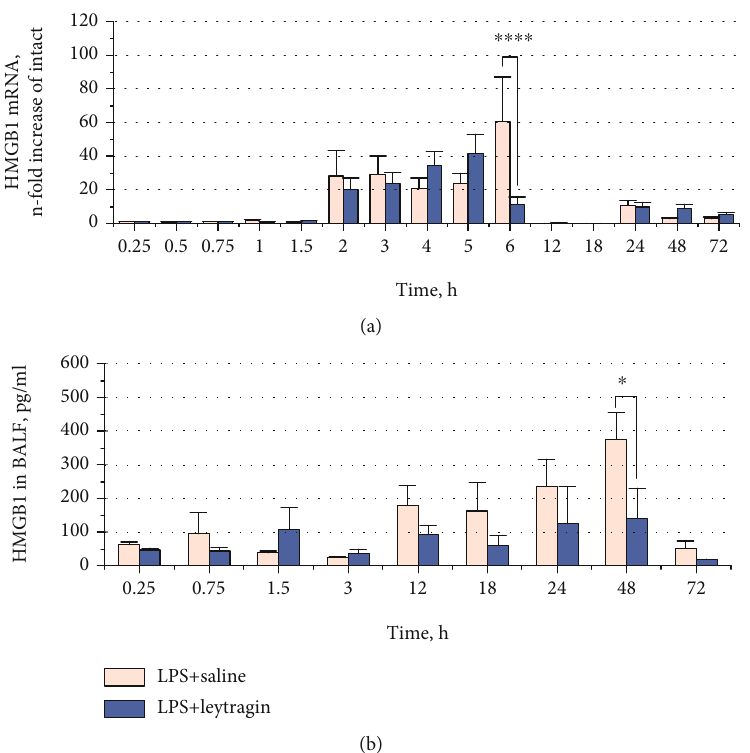
Figure 2: E ff ects of leytragin administration on LPS-induced elevations of HMGB1 release and mRNA levels. (a) Time courses for HMGB1 protein release into BAL in LPS-induced mice that received a single inhalation of leytragin or saline; 27 – 29 animals per group were used (3 – 4 per indicated time point). (b) The relative levels of HMGB1 mRNA in LPS-induced mice receiving inhalation of leytragin or saline; 75 animals per group were used (5 per indicated time point); ∗ p < 0 : 05 , ∗∗∗∗ p < 0 : 0001 vs. LPS+saline, two-way ANOVA, and post hoc Bonferroni ’ s test (see the text). Bars represent the mean ± SEM